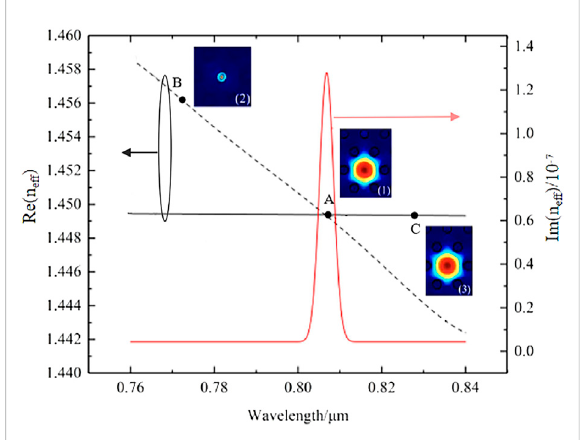
FIGURE 4 Dispersion characteristics (black solid line) and loss characteristics (red solid line) of core mode, as well as the dispersion characteristics (dotted black line) of SPP mode. (Illustrations(1)and(3)arethe fi elddistributionsofcoremode atpoints (A,C) .Illustration(2)isthe fi elddistributionofSPPmodeat point (B)